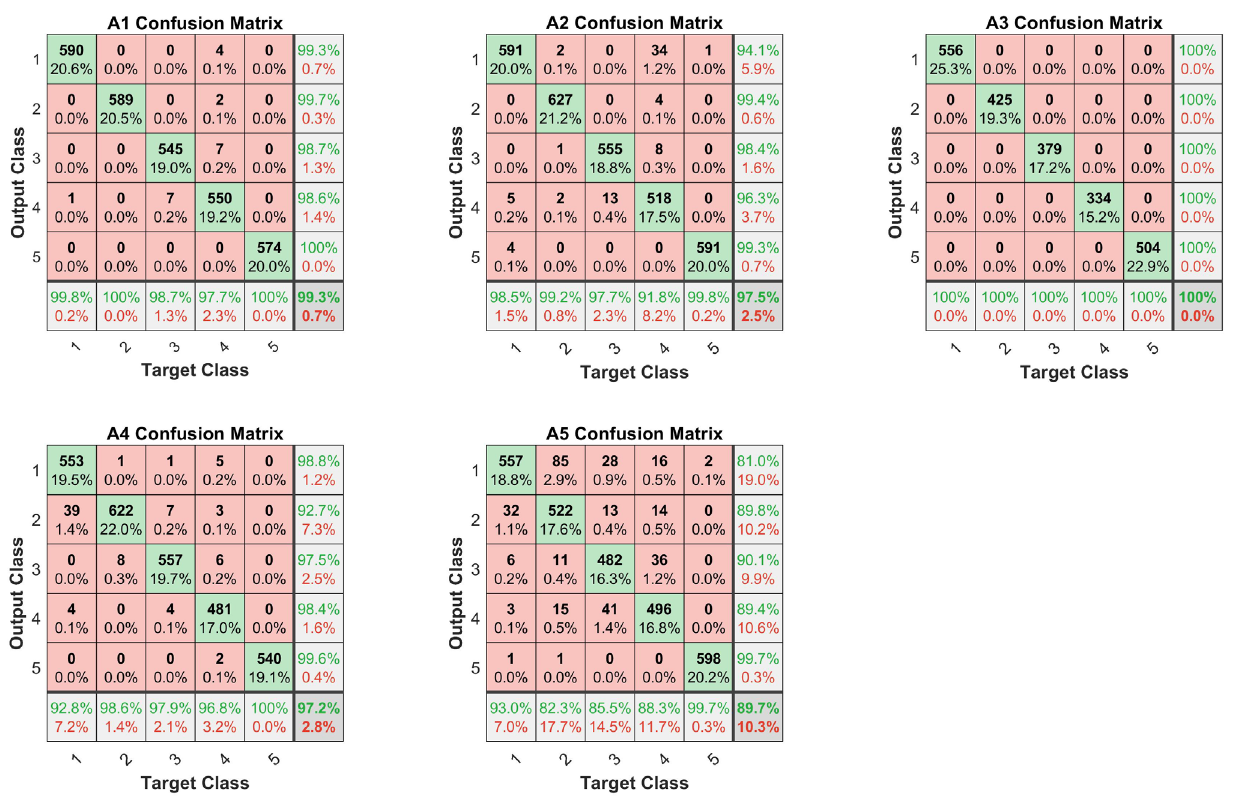
Figure 12. Confusion matrices for the TREE algorithm and first MRMR feature. Table 8. Goodness parameters of the TREE algorithm applied to first MRMR feature.